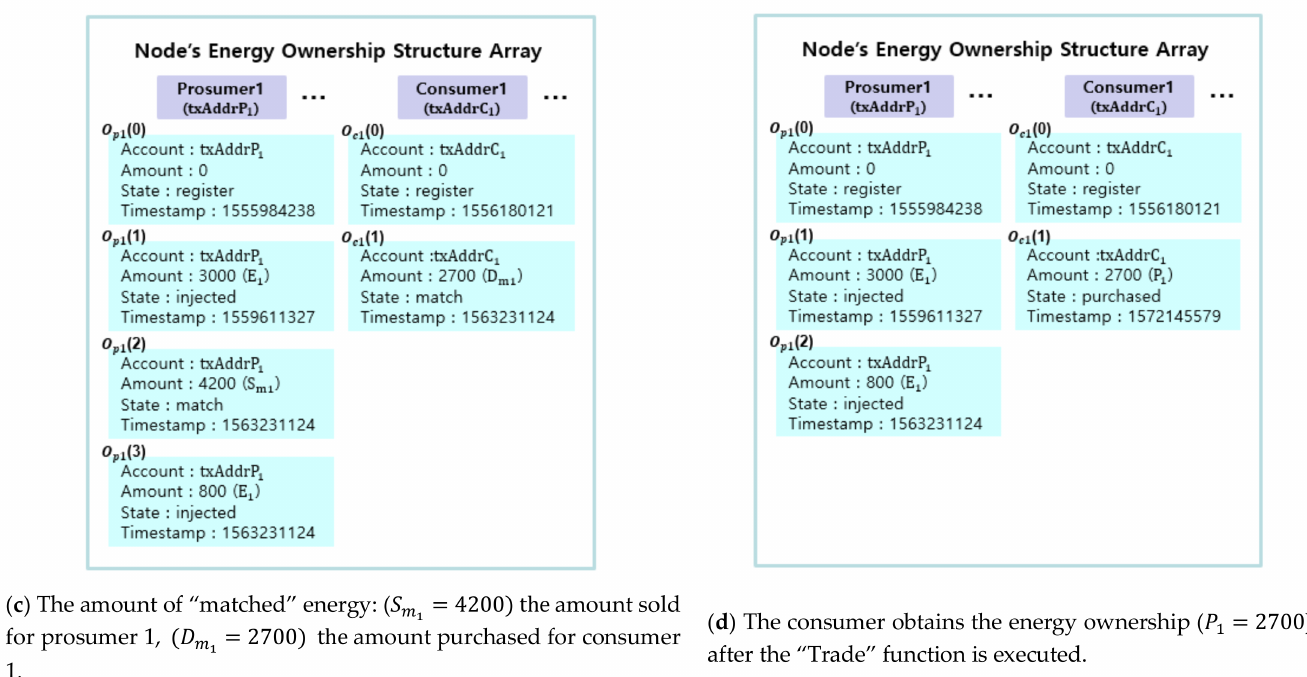
Figure 6. Illustration of change in the energy ownership in accordance with trading